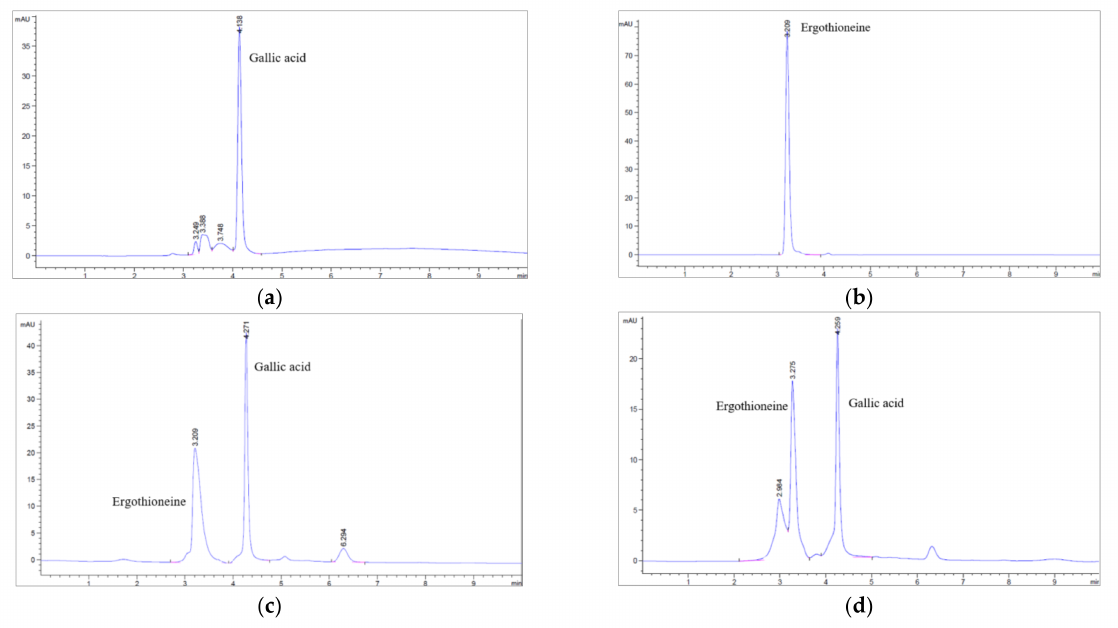
Figure 2. HPLC chromatograms of ( a ) gallic acid, ( b ) ergothioneine, ( c ) brown A. bisporus ethanol extract (EE), and ( d ) brown A. bisporus water extract (WE) using UV detection at a wavelength of 280 nm.